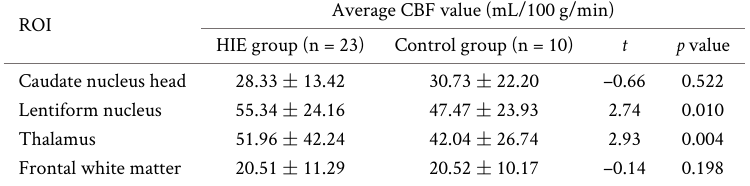
Table 2. The average CBF values in different brain areas of neonates (mean ± SD).